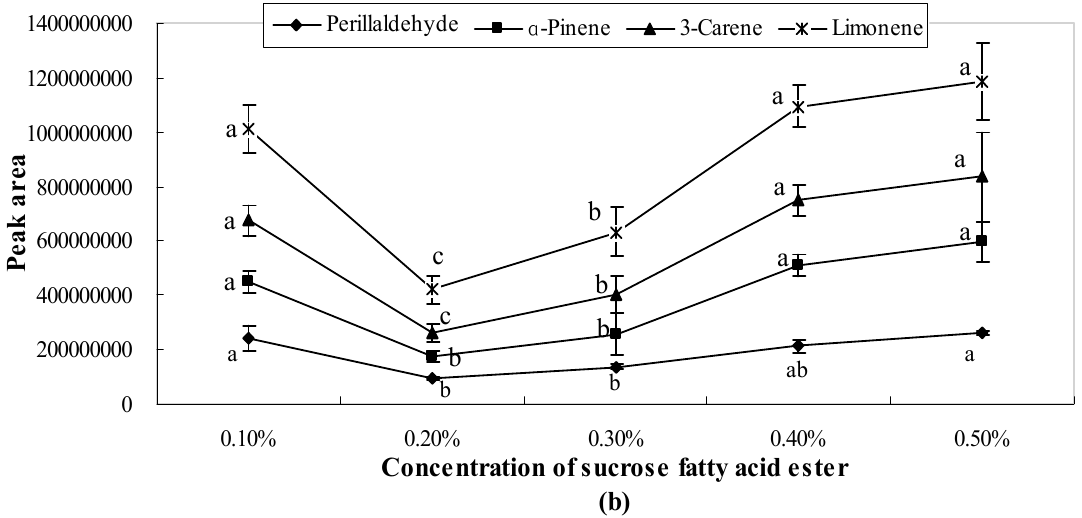
Figure 3. Effects of sucrose fatty acid ester on the release of ethyl acetate, ( E )-2-hexenal, carvone ( a ) and perillaldehyde, α -pinene, 3-carene, limonene ( b ). Significant differences ( p < 0.05) between different concentrations are performed by letters on the same polylines. Where the letters on the same polyline are the same, there is no significant difference between different concentrations.